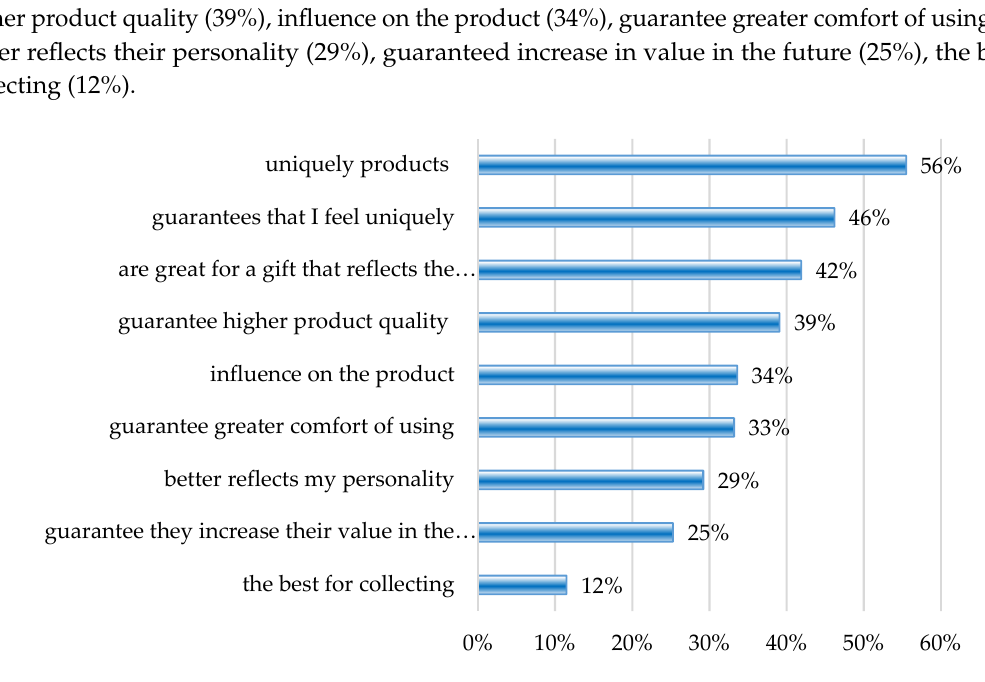
Figure 5. Acceptable waiting time for a personalized product. Source: own study.